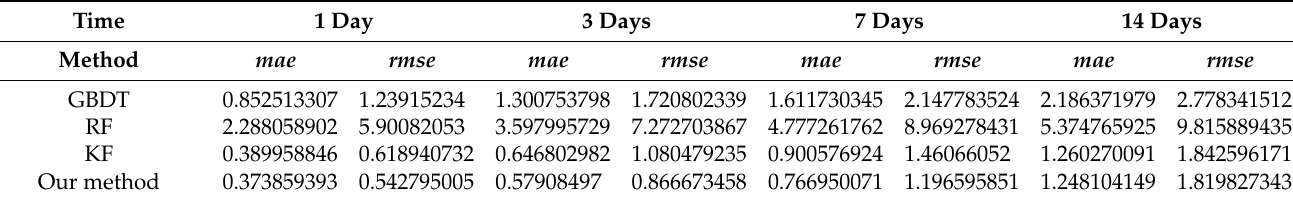
Table 1. Comparison of experimental results of different methods.